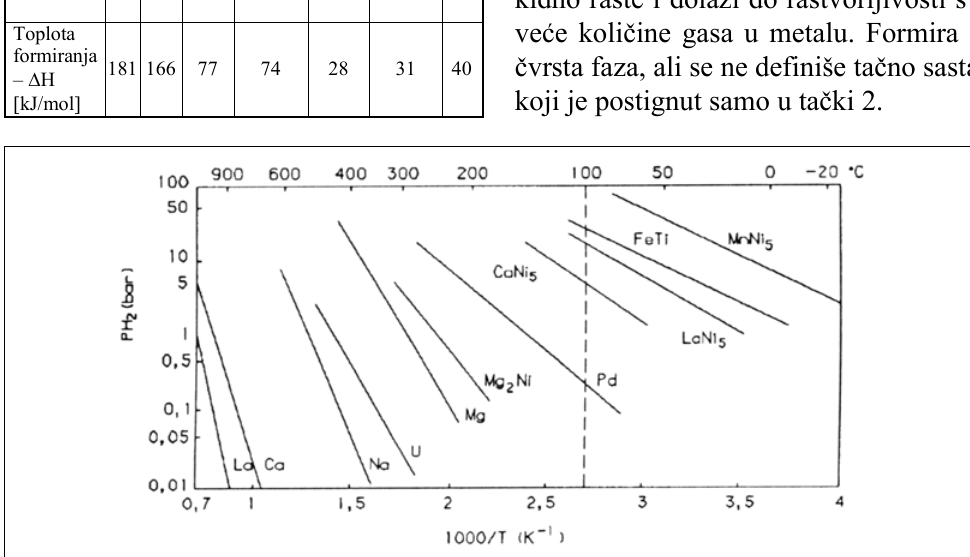
Toplota formiranja hidrida